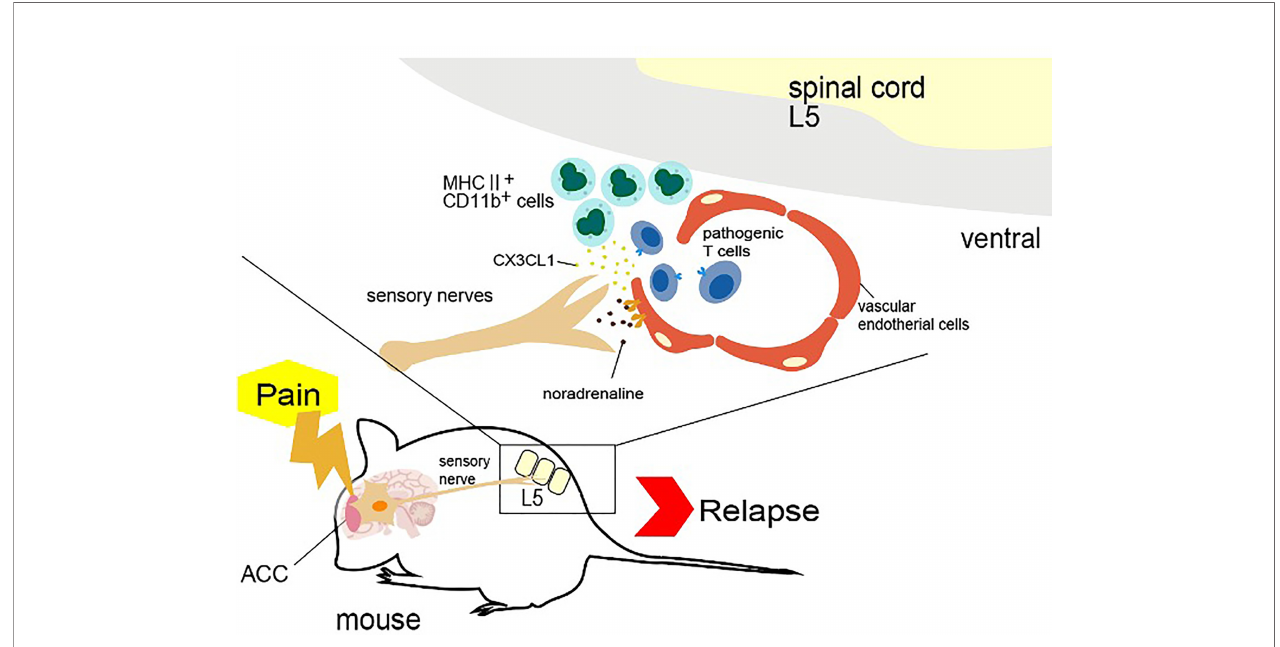
FIGURE 3 | Gravity gateway re fl ex. Gravity stimulation induces the activation of sensory nerves in the soleus muscles, which connects the fi fth lumbar vertebra (L5) dorsal root ganglion, followed by the activation of L5 sympathetic ganglion neurons. Norepinephrine (also known as noradrenaline) from the sympathetic nerves induces the IL-6 ampli fi er and the in fi ltration of autoreactive T cells into the spinal cord by upregulating CCL20 at the dorsal vessels of the L5